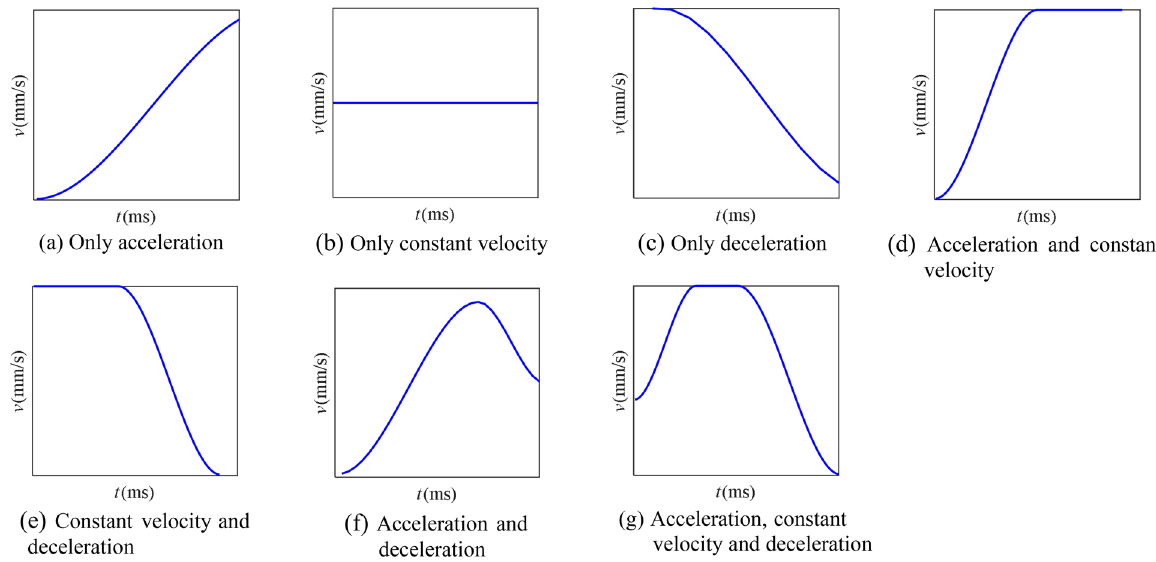
Figure 3 Velocity classification of double-quartic trajectory